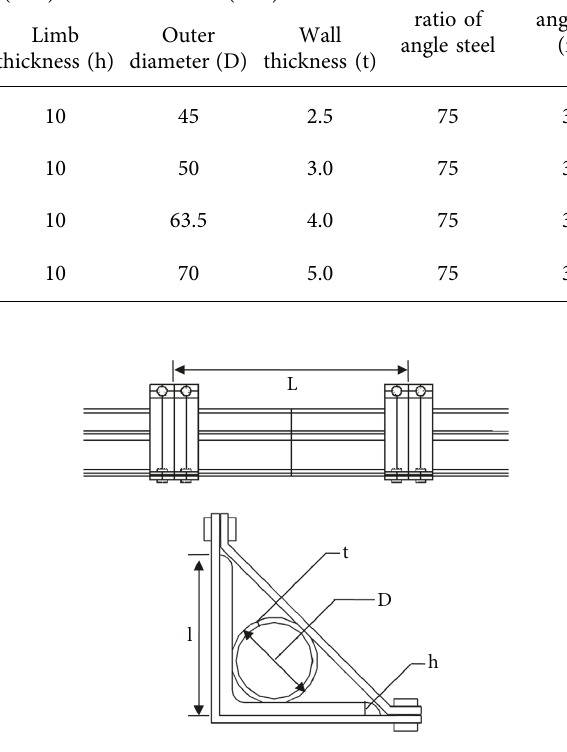
Figure 4: Fixture installation